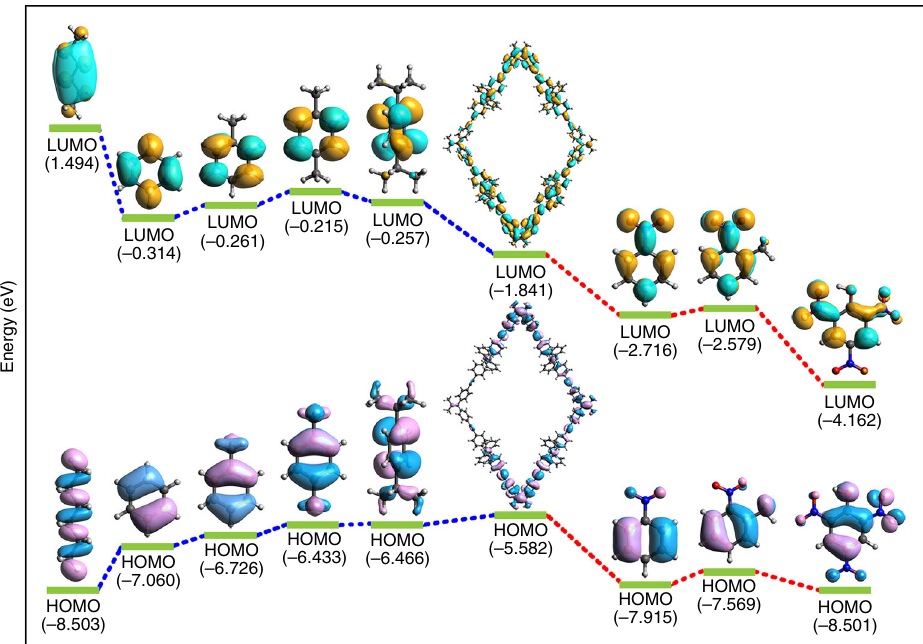
Fig. 7 DFT-calculated HOMO – LUMO energy pro fi les. HOMO – LUMO energy pro fi les of n -hexane, benzene, toluene, p -xylene, 1,4-diisopropylbenzene, NUS-24 fragment, nitrobenzene, 2-nitrotoluene, and 2,4,6-trinitrophenol (from left to